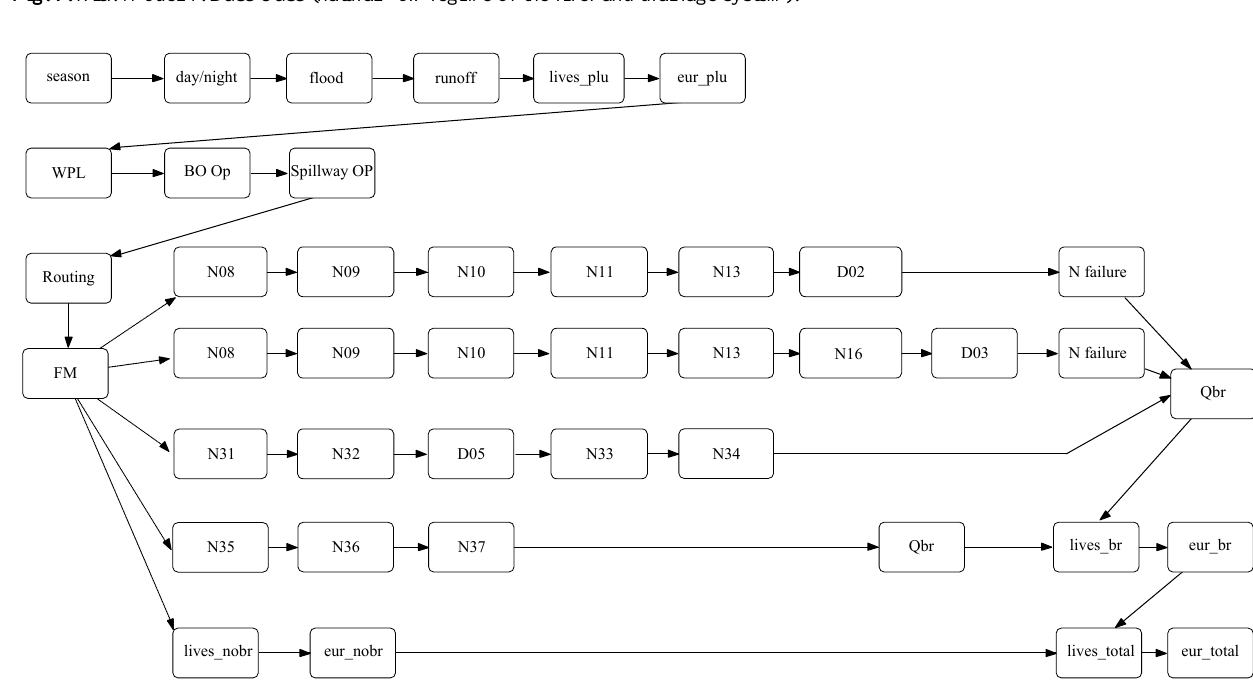
Fig. 7. Risk Model 1. Base Case (natural flow regime of the river and drainage system).